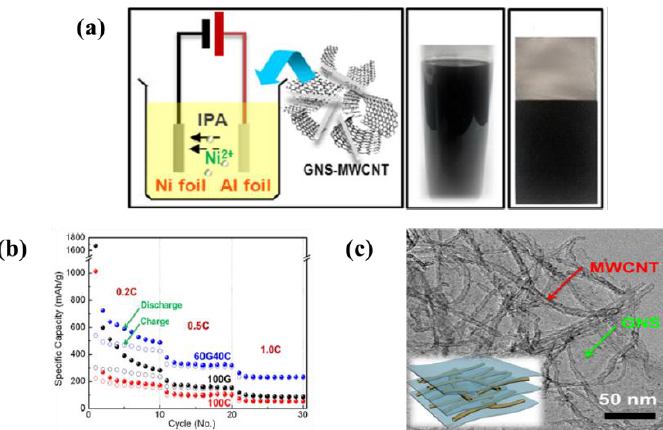
Figure 10. MWCNTs/graphene nanosheet composite prepared by EPD as the anode for Li-ion batteries: ( a ) Schematic representation of the electrophoretic deposition process, and MWCNTs/graphene nanosheet composite film deposited electrophoretically on Ni foil, respectively; ( b ) Cycling performance of the MWCNTs/graphene nanosheet composite electrodes at various current rates; ( c ) Typical HR-TEM image of 60G40C composites. The inset in the figure shows a schematic illustration of the MWCNTs/graphene nanosheet composites with uniform mixing.